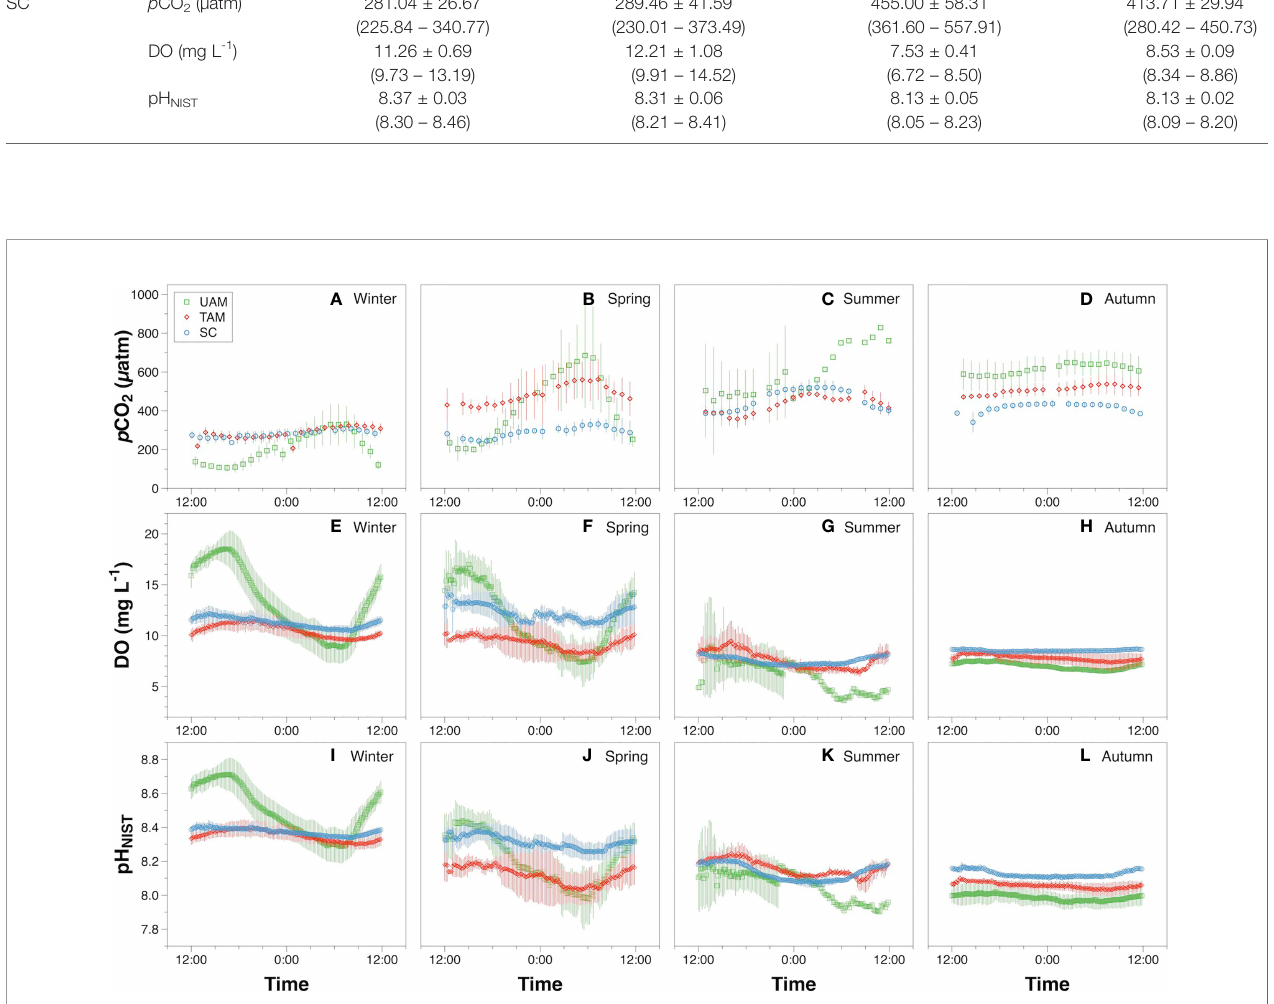
FIGURE 5 | The diel variation of p CO 2 (A – D) , dissolved oxygen (DO) (E – H) and pH NIST (I – L) at three macroalgal habitats (UAM, ulvoid algal mat; TAM, turf algal mat; SC, coexisting Sargassum horneri and crustose coralline algae) in four seasons. Values are means ± standard deviation. Green squares, red diamonds, and blue circles represent mean values over days 1~7 at the UAM, TAM, SC sites, respectively.